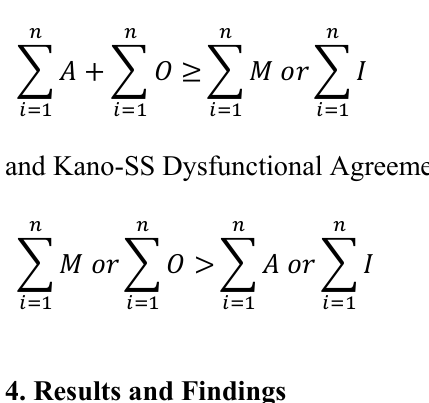
Table 2 Average of service satisfaction index Service variable (SV)